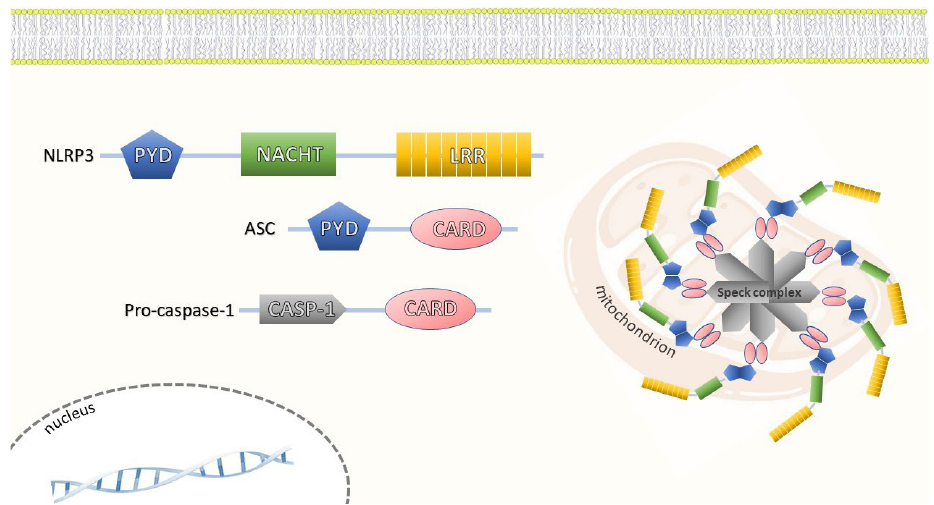
Figure 1. NLRP3 protein is composed of a leucine-rich repeat (LRR) domain at the C-terminus, a nucleotide-binding oligomerization (NOD or NACHT) domain in the middle and a pyrin domain (PYD) at the N-terminus [49]. The central NACHT domain provides the ATPase activity necessary for the NLRP3 activation and inflammasome formation [77]. Numerous studies revealed that the NLRP3 activity is likewise controlled by the various post-translational modifications [78] and many NLRP3-interacting proteins [79]. The NLRP3 inflammasome complex is composed of caspase-1 and an adaptor protein called apoptosis-associated speck-like protein (ASC) [47]. The ASC and pro-